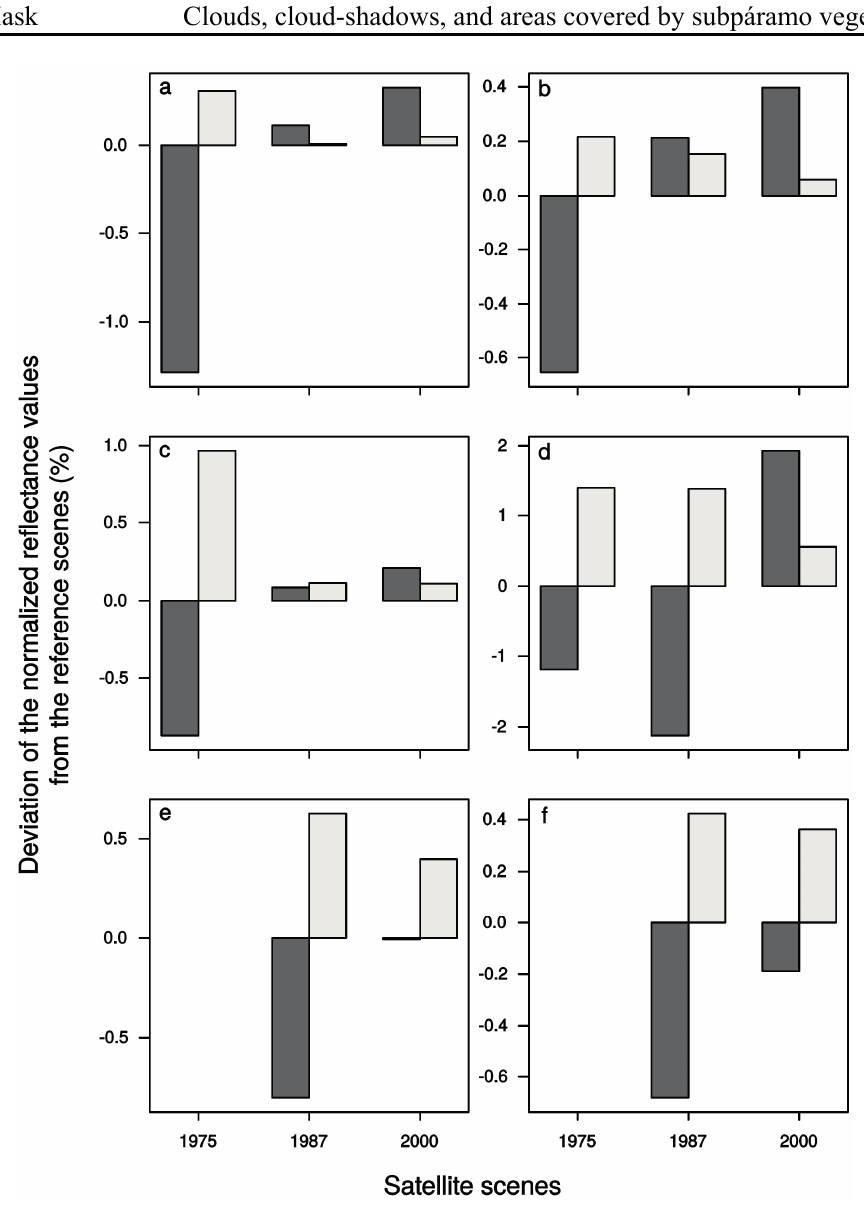
Figure 4. Deviation of the normalized reflectances from the reference scenes (1980 and 2001) for a no-change subset of forest, before (dark bars) and after (bright bars) the intercalibration, in the ( a ) blue; ( b ) green; ( c ) red; ( d , e ) NIR 1 & 2; and ( f ) MIR bands of the Landsat satellite images of 1975, 1987, and